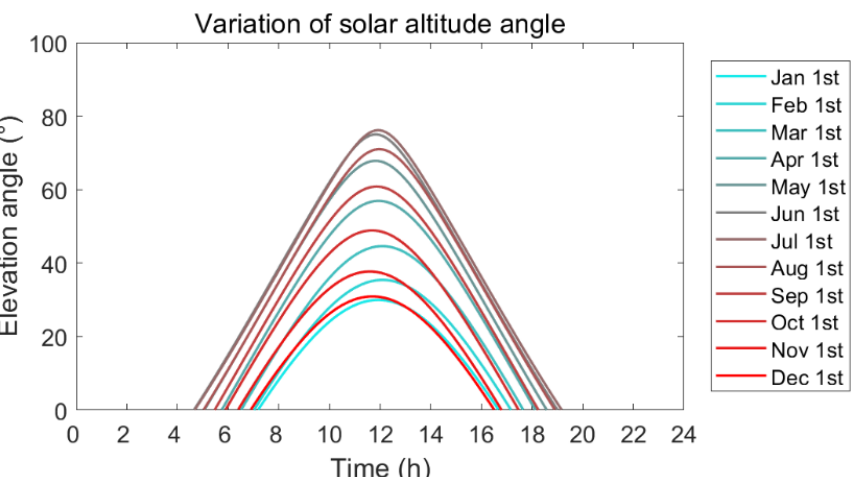
Figure 4. Variation of the solar altitude angle on the first day of each month in 2019. The horizontal coordinates indicate the time of day in hours; the vertical coordinates indicate the solar collector tilt angle in degrees; the different curves indicate the first day of the different months. The location is 37° N and 122° E.